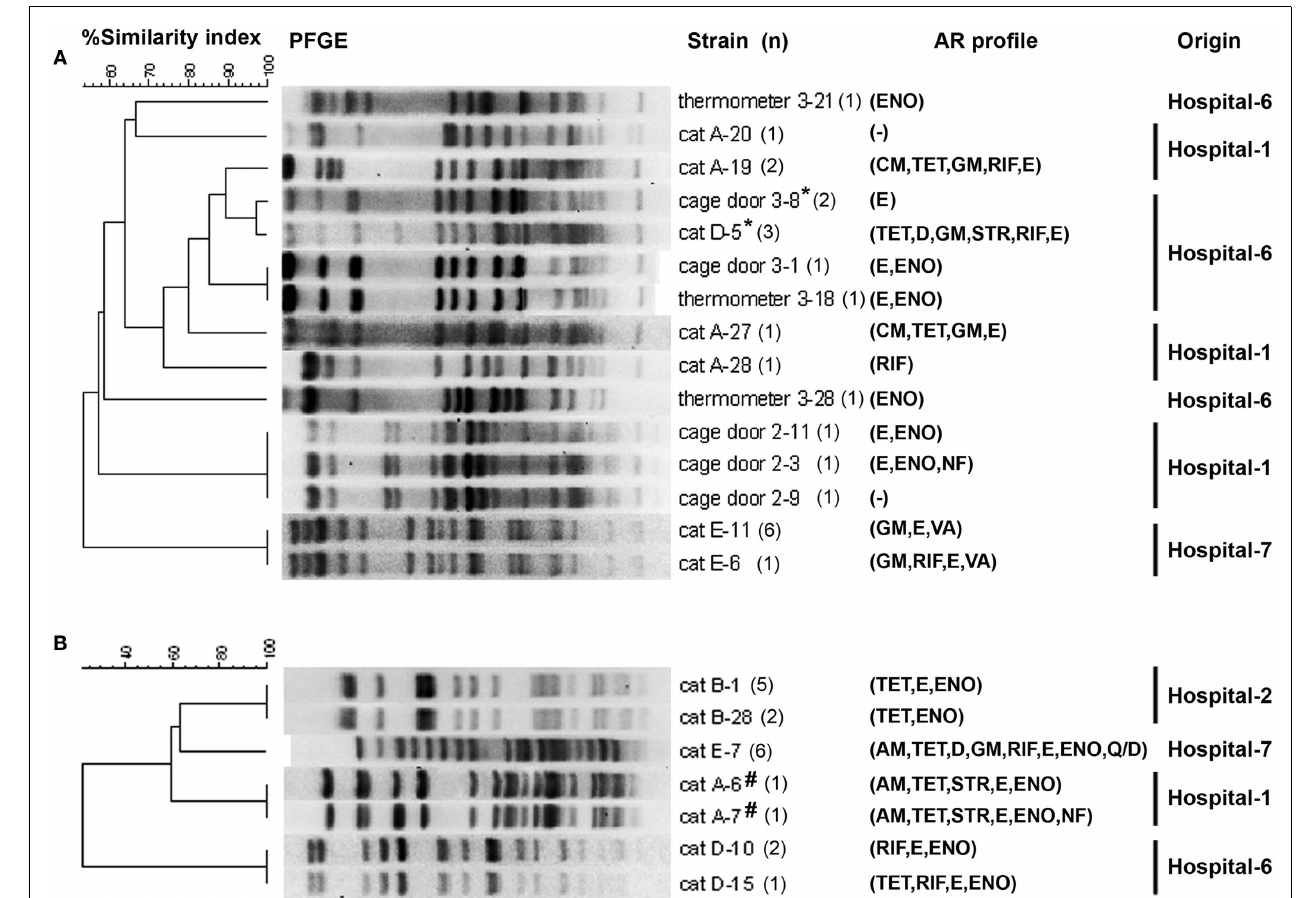
FIGURE 2 | Dendrograms based on SmaI restriction pattern resolved by pulsed-field gel electrophoresis (PFGE) depicting the relationships among representative isolates of (A) E. faecalis (feline, n = 15; surface, n = 9) and (B) E. faecium (feline, n = 18) in small animal veterinary hospitals. Strain numbers, number of strains typed ( n ), antimicrobial resistance (AR) profiles, and corresponding hospitals are included along each PFGE lane. “*” Indicates 96.9% similarity among E. faecalis isolated from the hospital surface and cat feces. “#” Indicates 100% similarity to E. faecium